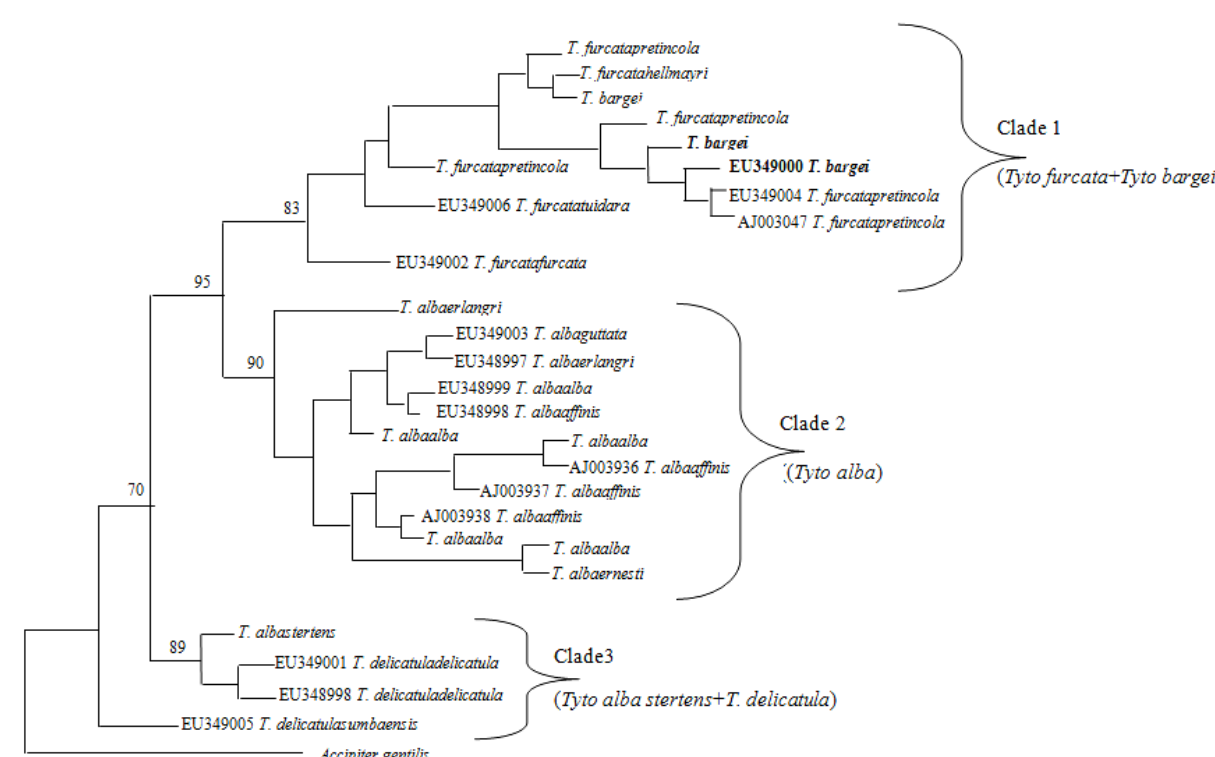
F IGURE 3. NJ tree obtained from combination of all sequences of Wink et al. 2008 and our CYTB data set.